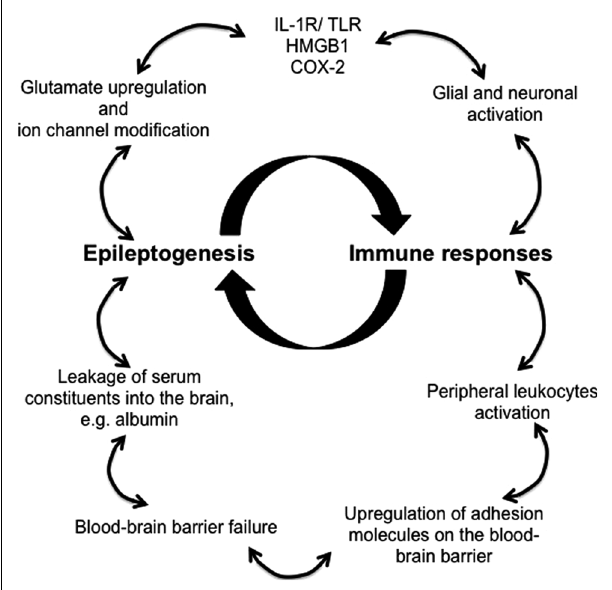
FIGURE 1 | Proposed immune mechanisms in epileptogenesis .The relationship between the immune system and the development of epilepsy is non-linear, but rather better represented as an amplifying feedback loop. The immune response predisposes, precipitates and perpetuates epileptogenesis through activation of resident brain cells (glia and neurons) and facilitation of peripheral leukocyte infiltration.These immune mediators release proinflammatory cytokines and chemokines into the brain parenchyma and the blood, thereby activating downstream signaling cascades and compromising blood–brain barrier, which leads to pathophysiological outcomes, reoccurrence of seizures, and ultimately the development of